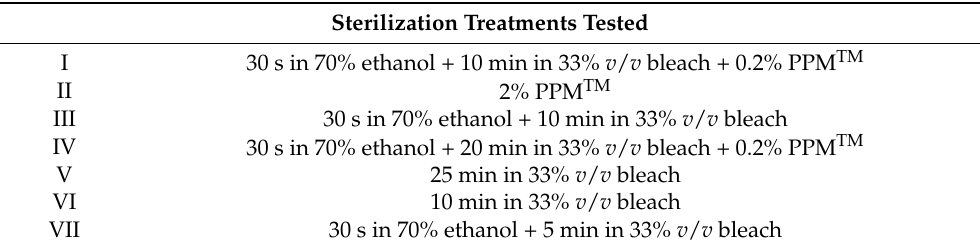
Table 1. Treatments tested for explant